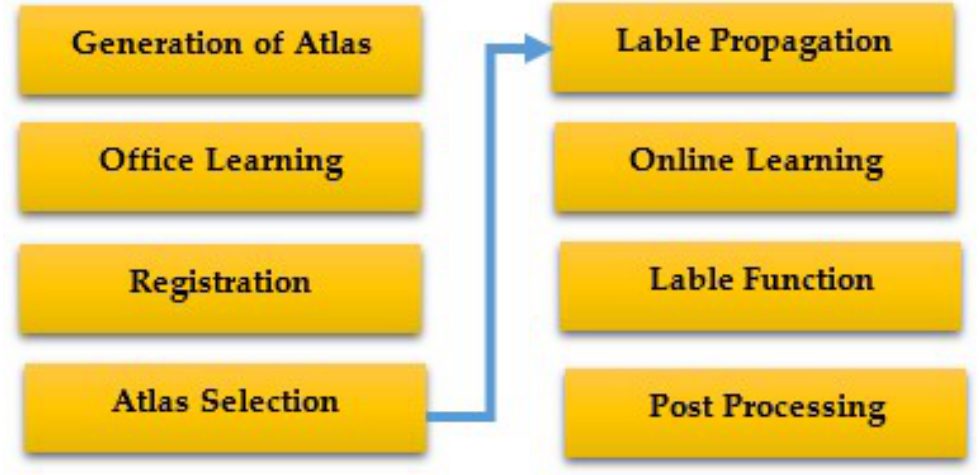
Figure 5. The fundamental components of a standard MAS algorithm [31].